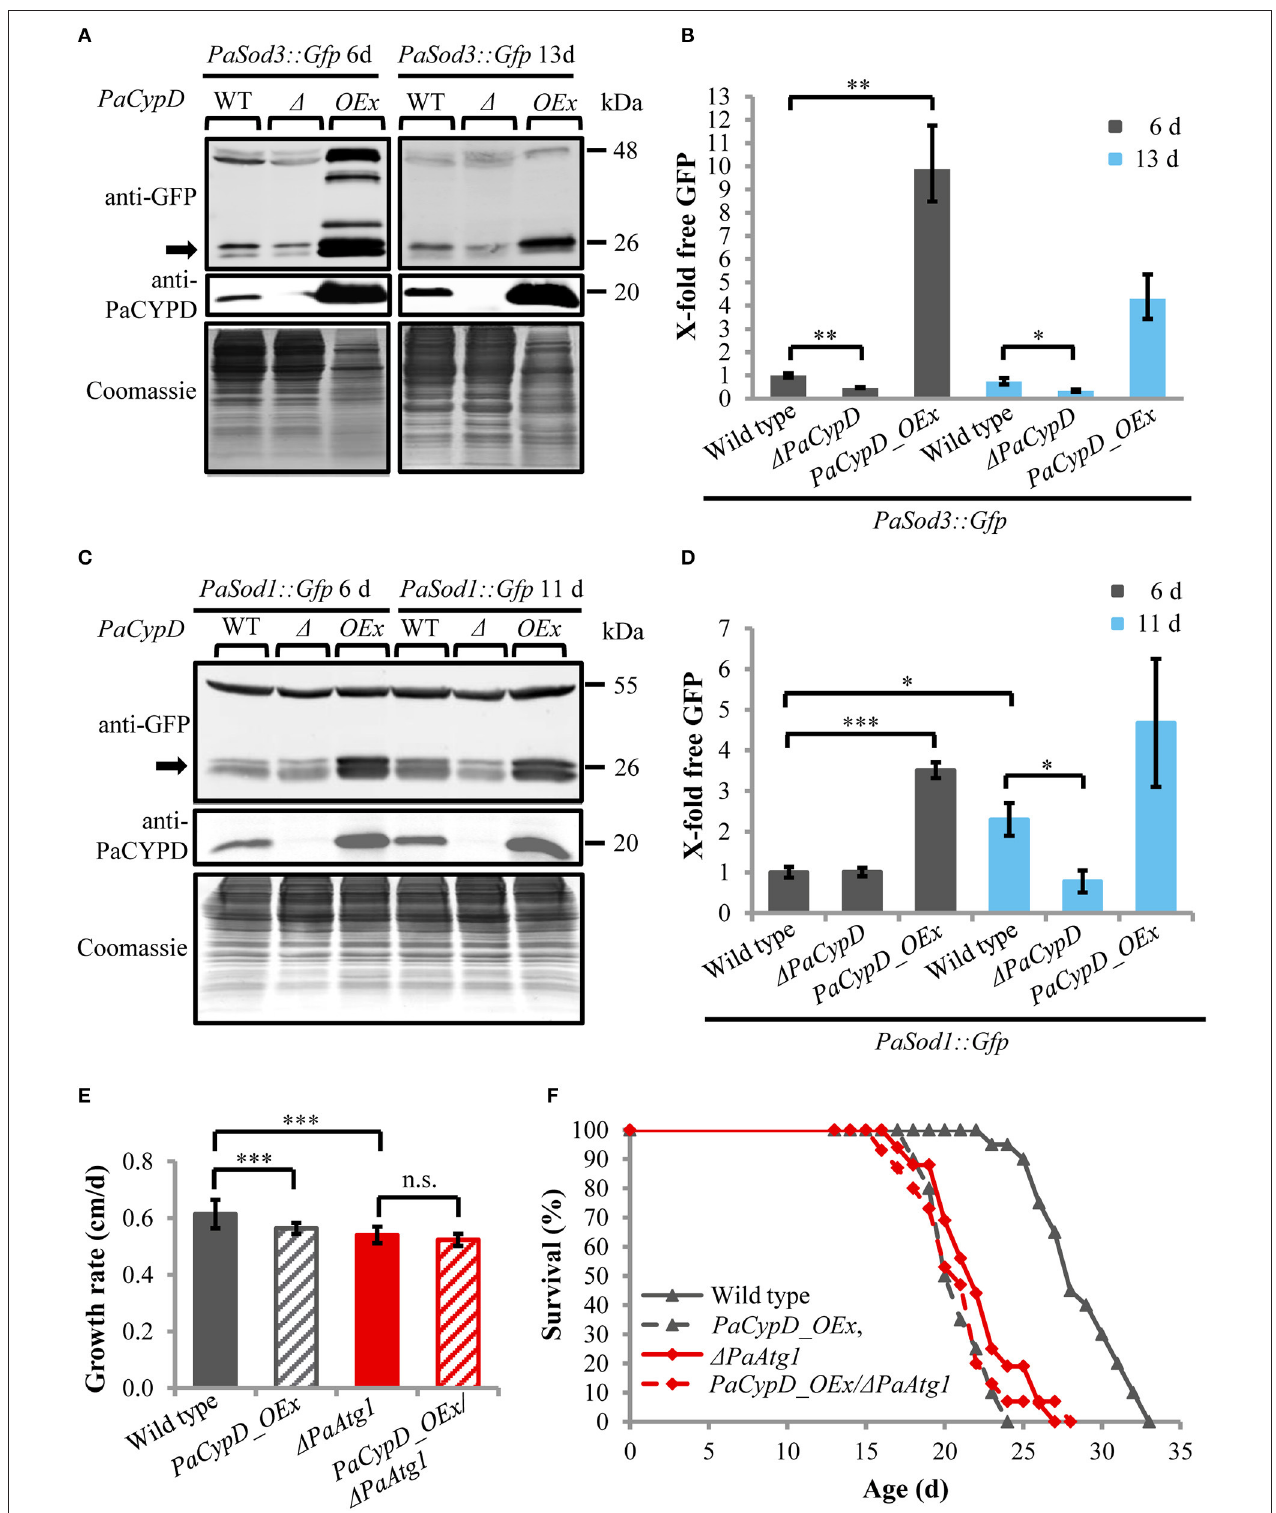
FIGURE 2 | Autophagy-dependent degradation of mitochondrial and cytosolic marker proteins in wild-type strain and different PaCypD mutants during aging. (A) Monitoring mitophagy by western blot analysis using the mitochondrial protein PaSOD3::GFP. 6 and 13 d old wild-type (WT), ∆ PaCypD and